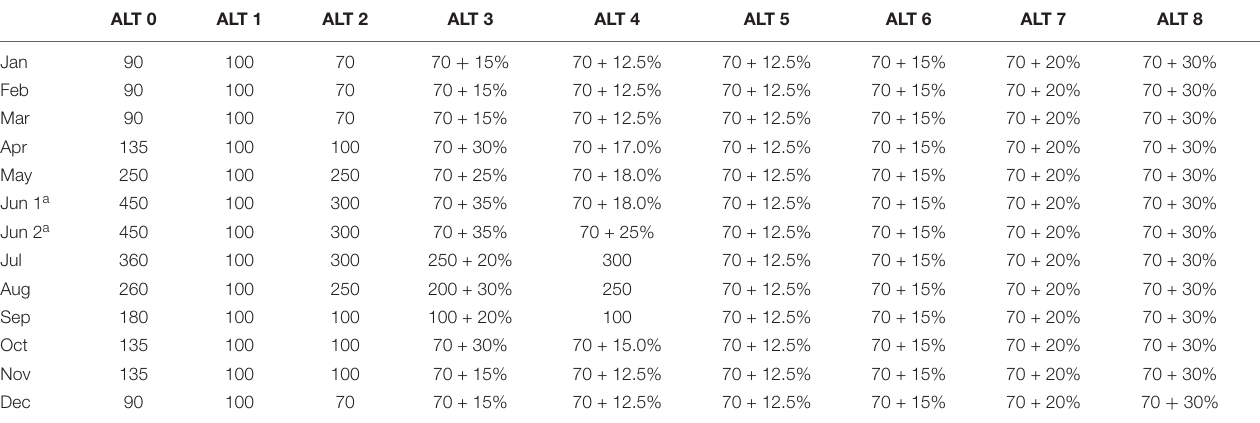
TABLE 2 | Monthly values of the environmental flow releases (l/s) defined for the nine considered alternatives: the percentage values represent a percentage of the watercourse discharge measured upstream of the withdrawal point, while the other numerical values are the fixed flow rates in l/s defined by the involved stakeholders. ALT